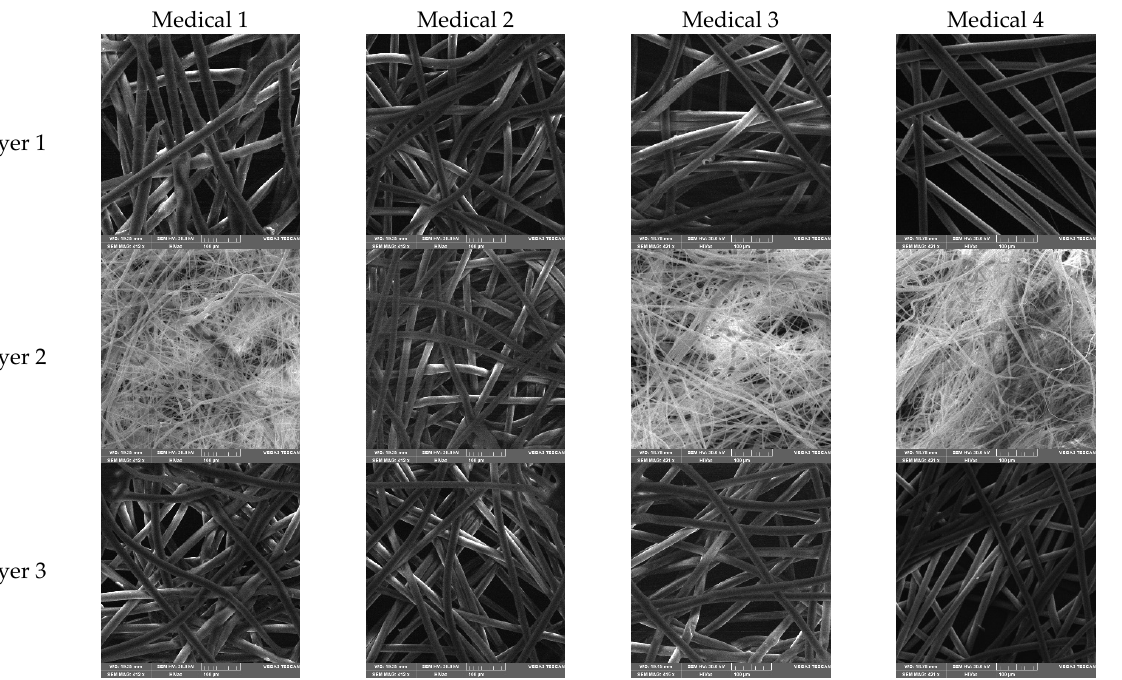
Figure 10. SEM pictures of the layers composing the medical masks. A denser structure with thinner filaments is present in layer 2 of the Medical masks n. 1, 3 and 4.